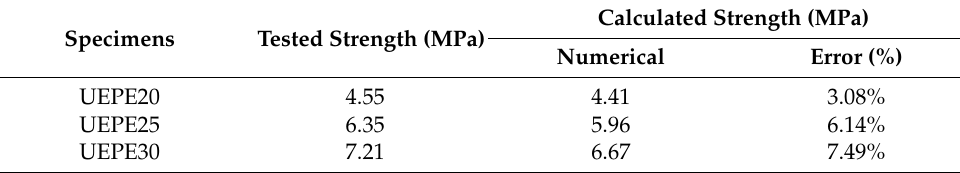
Figure 13. Comparison between the test and calculation load-deflection curves. Table 9. Comparison between the test and calculation flexural tensile strengths.